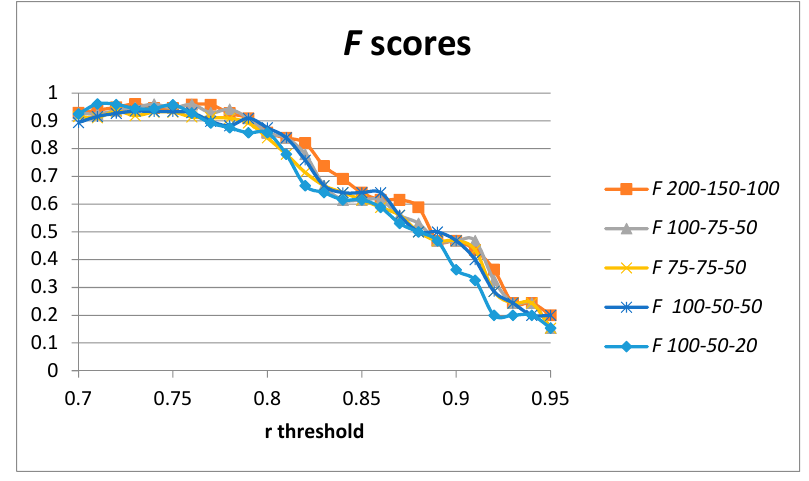
Table 4. Optimal values for the F score for each configuration.